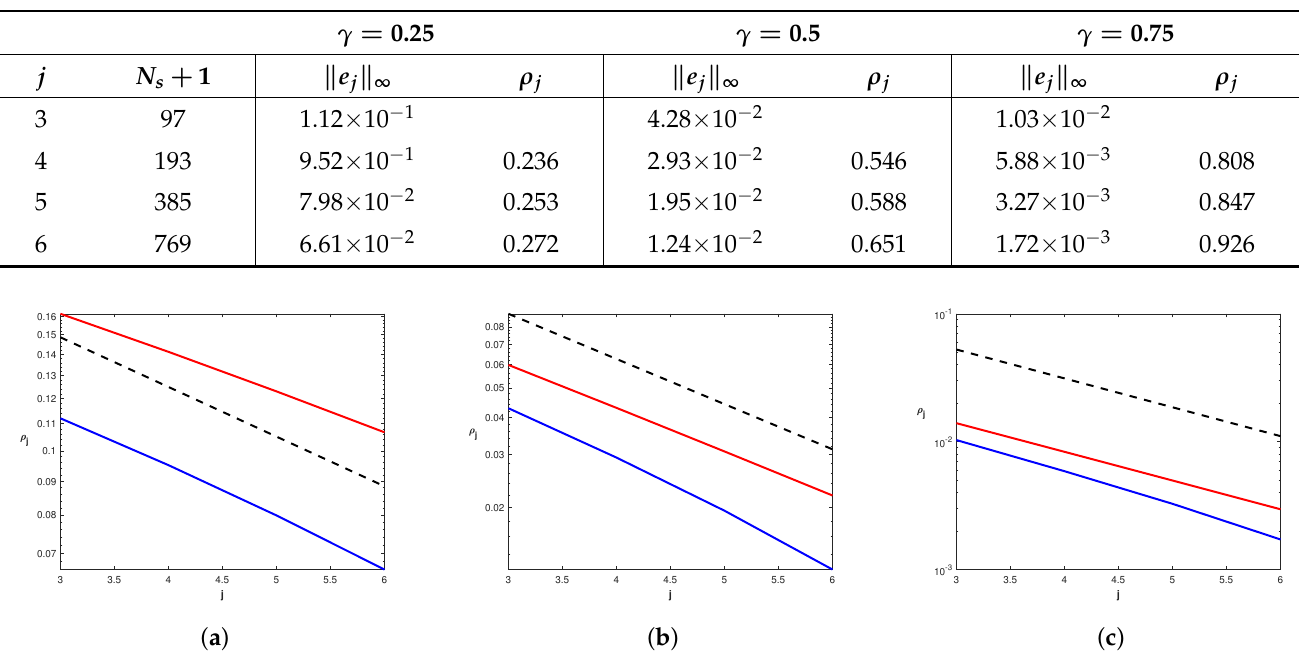
Table 5. Example 2: The infinity norm of the error and the numerical convergence order for different values of the fractional derivative γ and the refinement level j when using dQ 3 j y with r = 2 (cf. (27)). The number of collocation points is N s + 1 = 2 j 6 + 1.